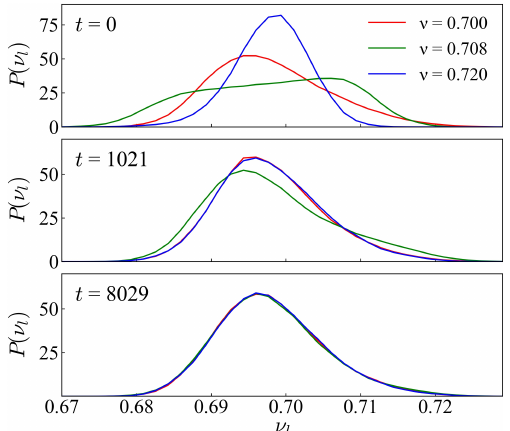
Figure 4. The time evolution of the local density distribution at ν = 0 . 700, 0 . 708, and 0 . 720, respectively. The di ff erence of shape between initial and final distribution might cause the po- tential substantial factor of slow